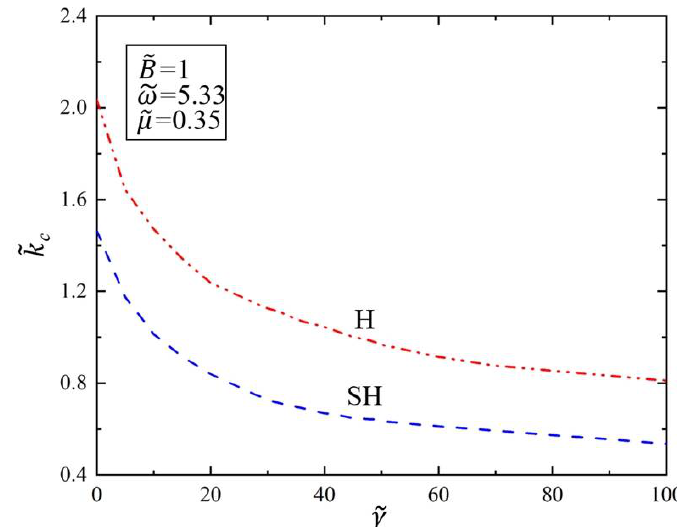
 Figure 6. Variation of the critical wave number (cid:101) k c of Faraday instability with surface tension (cid:101) γ . The k of Faraday instability with surface tension   Figure 6. Variation of the critical wave number c dimensionless parameters are (cid:101) ω = 5.33, (cid:101) µ = 0.35, (cid:101) B = 1. The critical wave number (cid:101) k c decreases as  . The dimensionless parameters are the surface tension (cid:101) γ